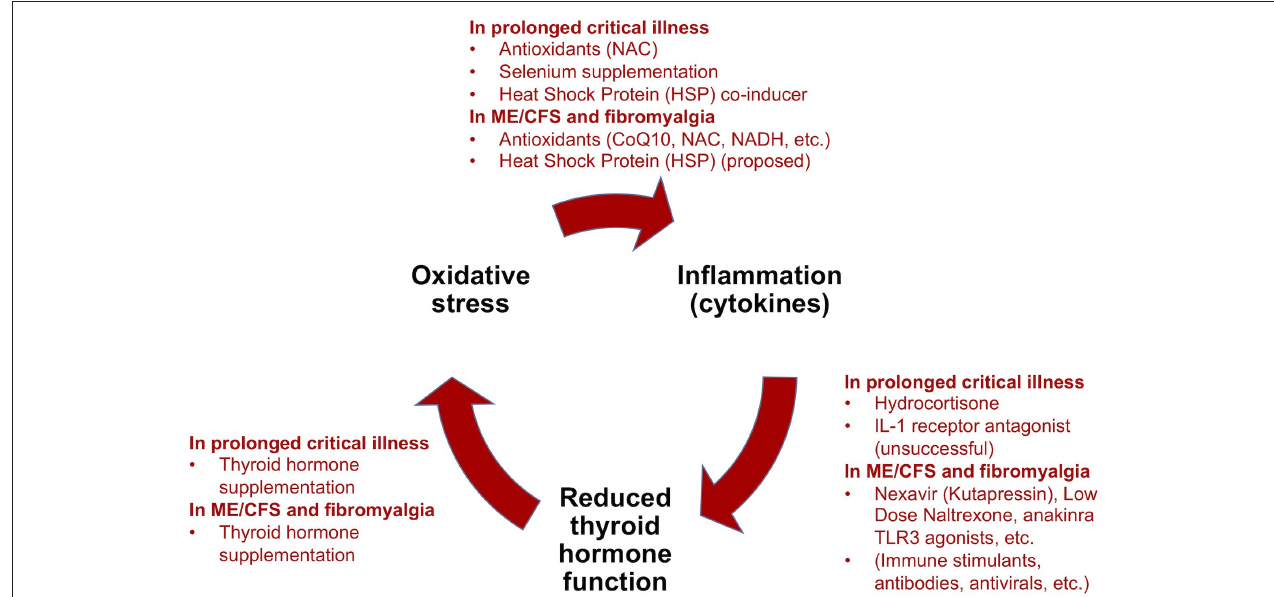
FIGURE 5 | Summary of treatment trials for prolonged critical illness using the “vicious circle” model as a framework, and analogous experimental treatments for ME/CFS and fibromyalgia [modified from (